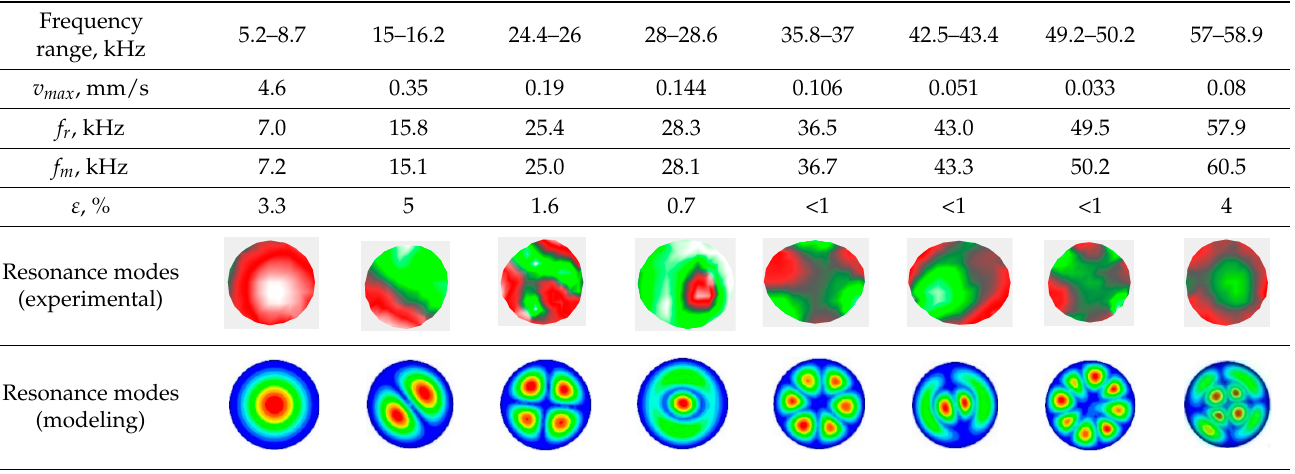
Table 1. Modeling results and experimental data on spectral characteristics of electric pulse emitter.